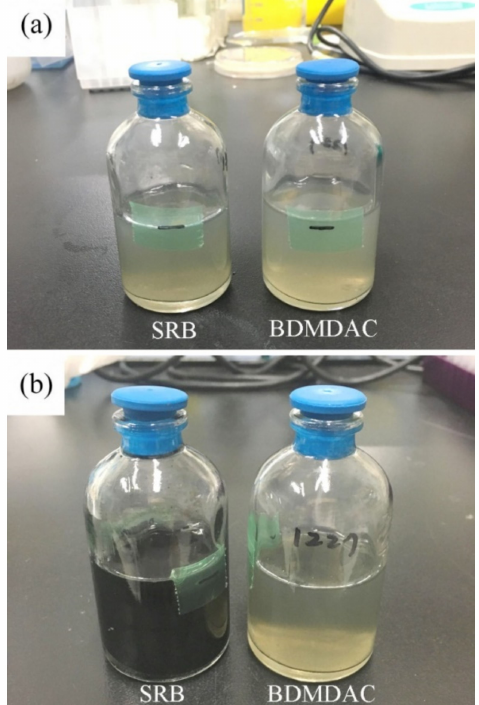
Figure 2. Visual inspection of the D. desulfuricans -inoculated medium with and without BDMDAC after ( a ) 7 days and ( b ) 28 days of